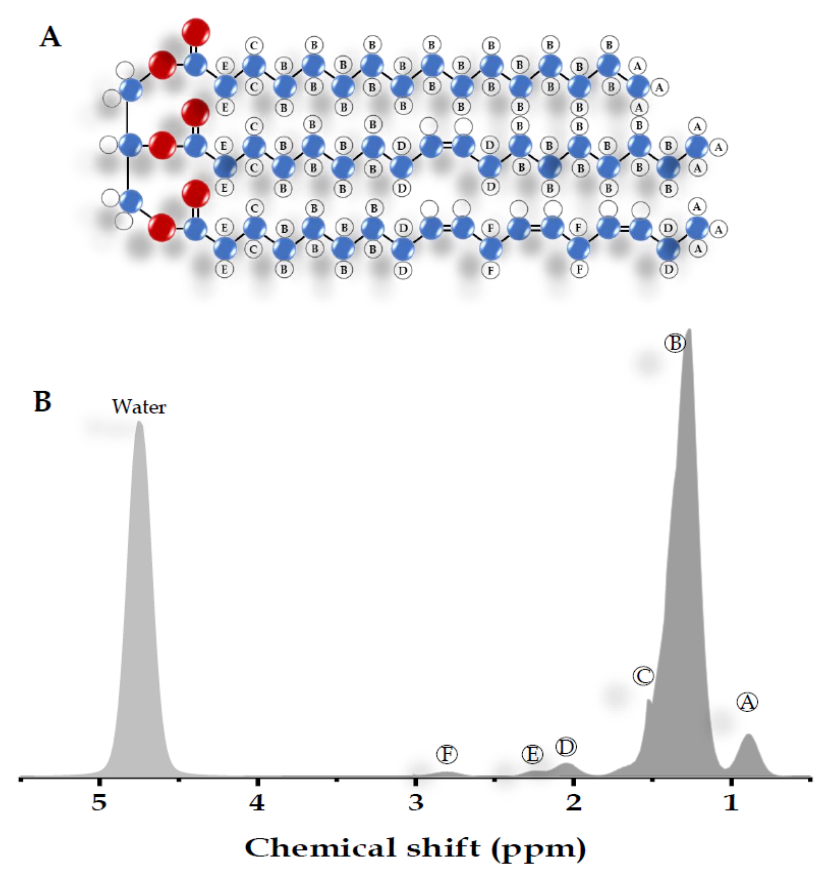
Figure 2. Schematic illustration of a triglyceride molecule and MR spectrum from the liver. ( A ) The molecular structure of the triglyceride. Hydrogen atoms are shown in white ( ○ ), carbon in blue ( ● ), and oxygen in red ( ● ). ( B ) The spectrum of all molecules obtained from the liver corresponding to the hydrogen atom position on the molecular structure of a triglyceride.